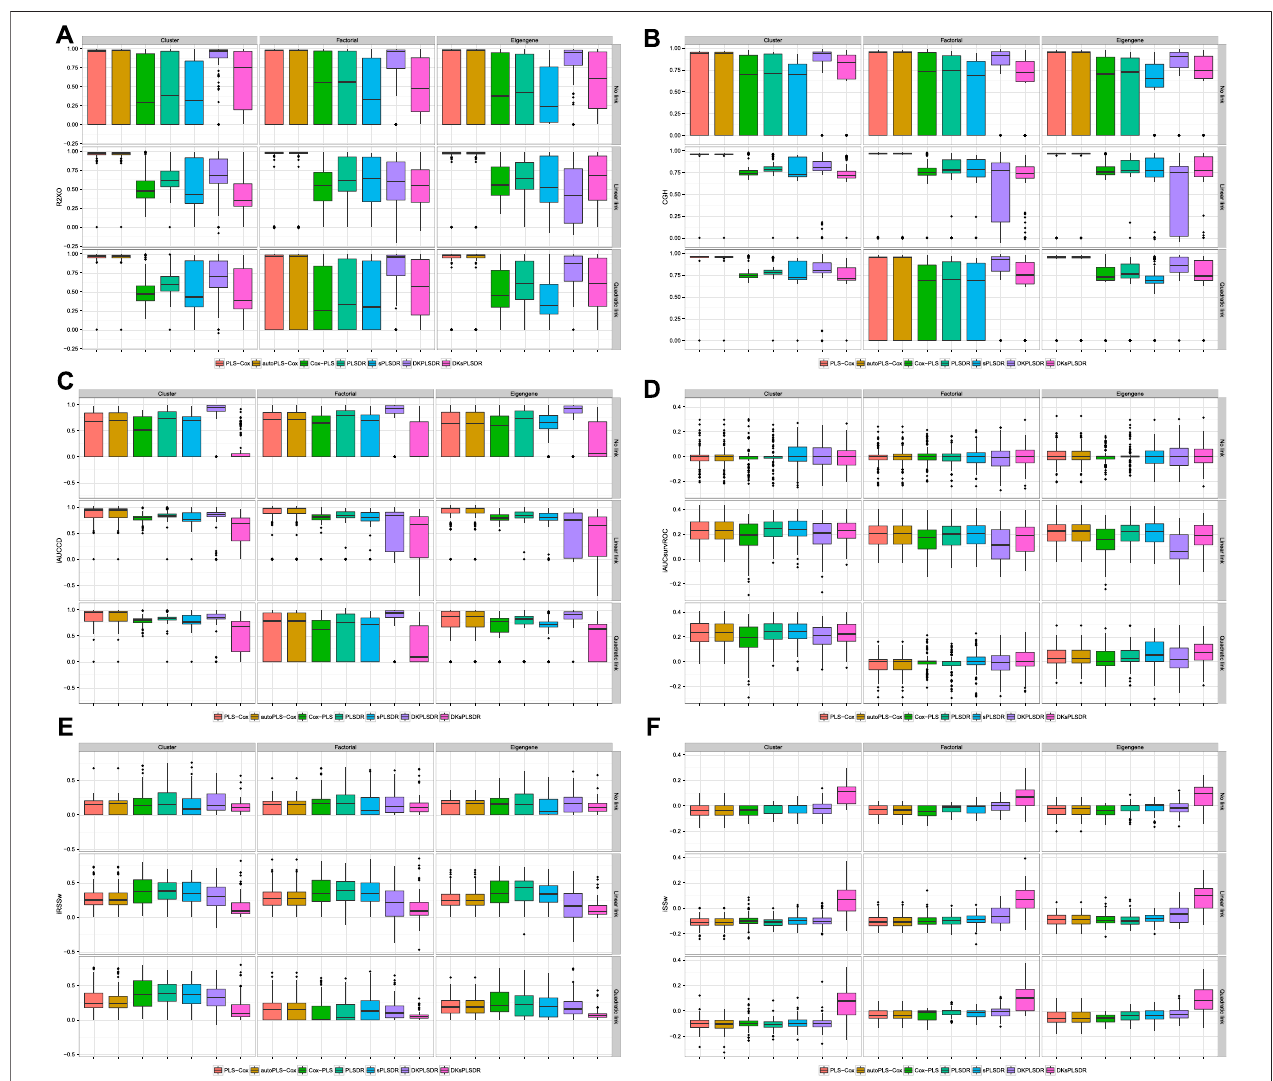
FIGURE 6 | Deltas (iAUCSurvROC CV − vHCVLL), panel by measure. panel (A) : R2XO measure. panel (B) : GHCI measure. panel (C) : iAUCCD. panel (D) : iAUCSurvROC. panel (E) : iRSSw measure. panel (F) : iSSw measure.